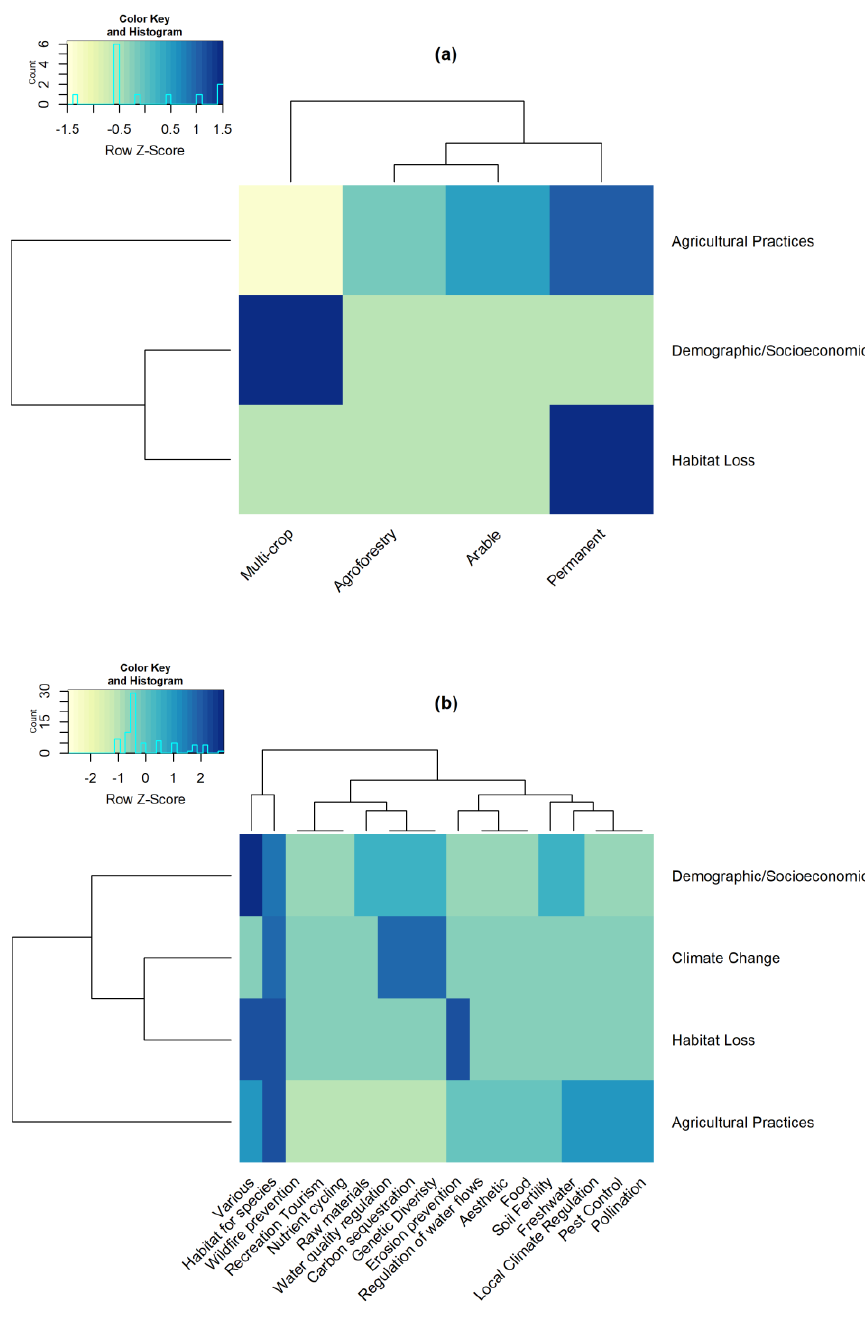
Figure 5. Association between drivers and pressures (rows) and ( a ) cropping system and ( b ) ecosystem service (columns). Dendrograms obtained through hierarchical clustering, and using Euclidean distance, represent similar association of studies in terms of the considered pressures and cropping system or ecosystem service stage.